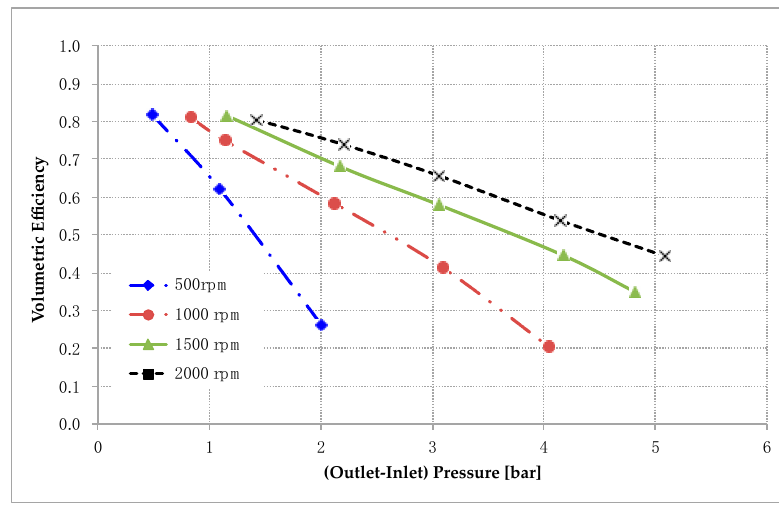
Figure 17. mTGp volumetric efficiency POM inner gear performance with ‘in-out sleeve passageway’ configuration.